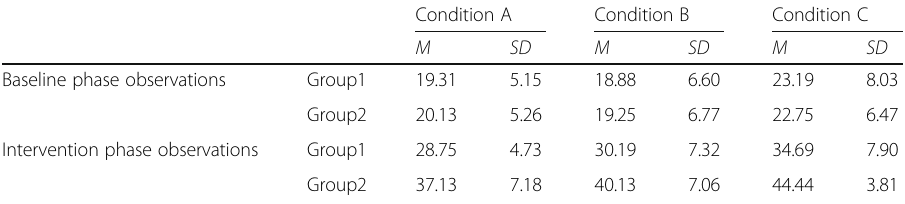
Table 3 Means and standard deviations per group and per condition